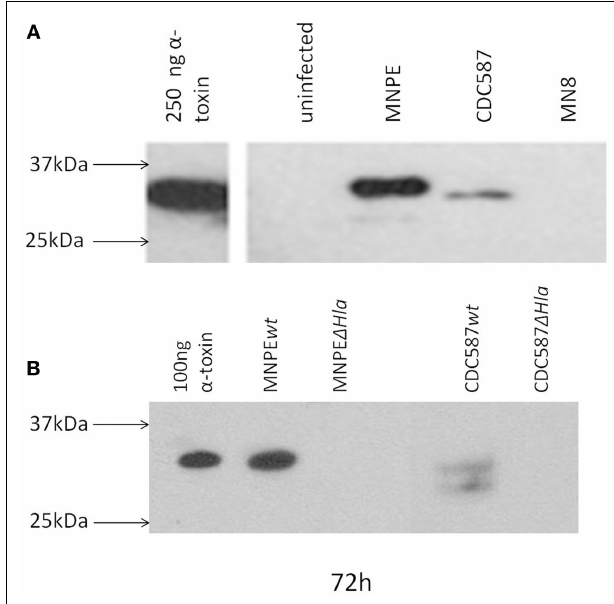
FIGURE 3 | α -Toxin is detected in the mucosa after infection. Detection of α -toxin in explants of porcine vaginal mucosa by western immunoblotting. At 72h post-infection with different strains of S. aureus , explants were transferred to tubes containing 250 μ l PBS and homogenized for 30s. Homogenates were clarified by centrifugation and concentrated fivefold by ethanol precipitation. Proteins were separated by SDS-PAGE on a 4–20% gradient gel, transferred and probed with rabbit anti- α -toxin serum. (A) Based on the position of purified α -toxin, full-length α -toxin is only detected in tissue infected with MNPE.Truncated forms were detected in CDC587 and MNPE-infected tissue. No bands were observed in tissue infected with MN8 or in uninfected tissue. (B) No bands were detected in hla KO